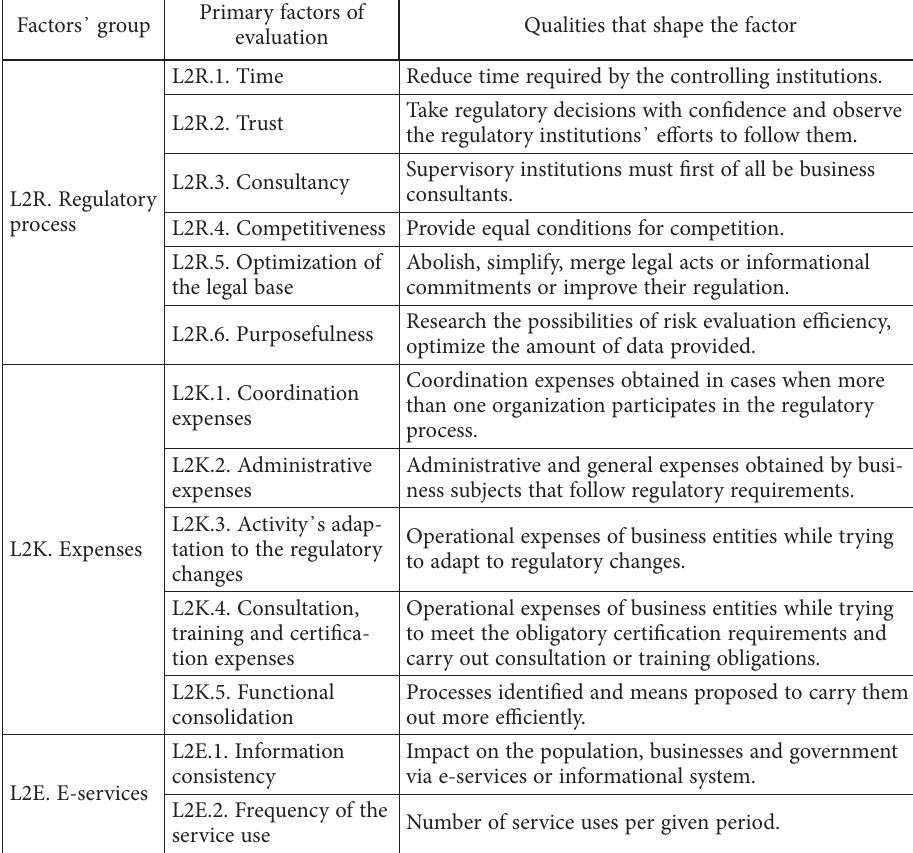
Table 4. Factors᾽ classification on the business entities’ level (created by the authors) Primary factors of Factors᾽ group evaluation